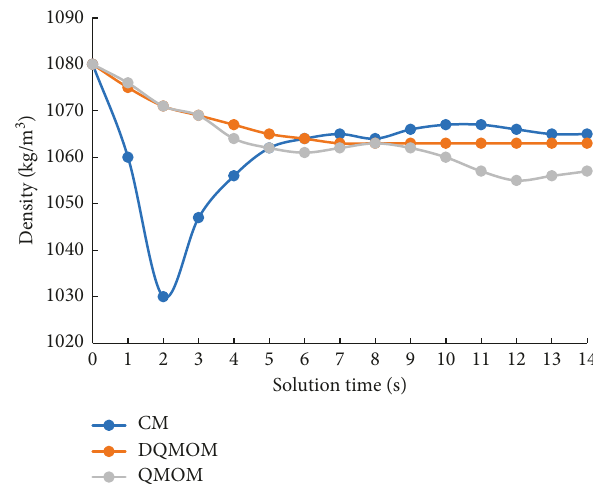
Figure 5: Comparison of the time evolution of the density of mixture using three